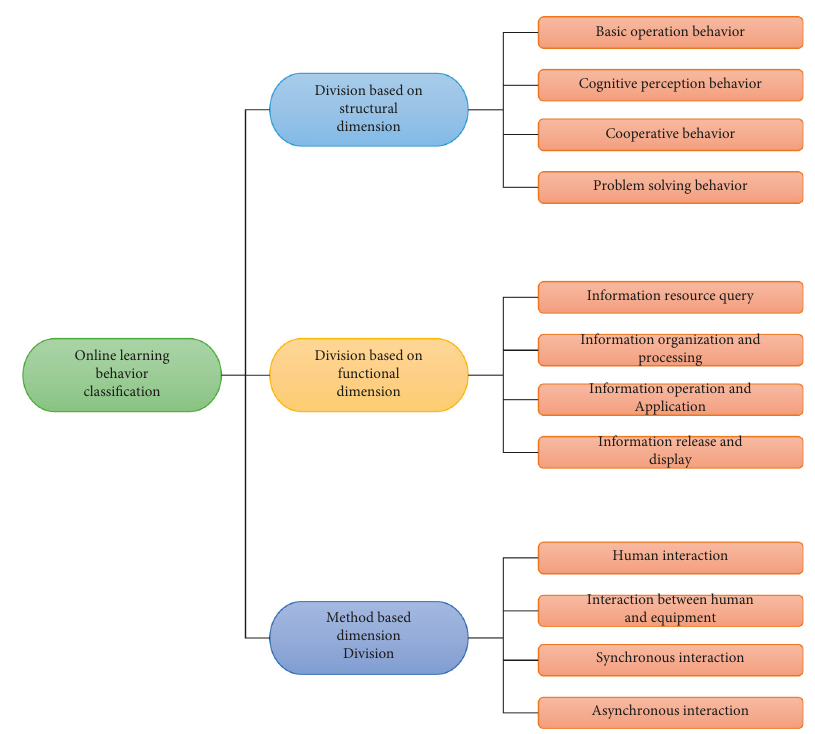
Figure 3: The classification diagram of online learning behavior based on artificial intelligence theory.